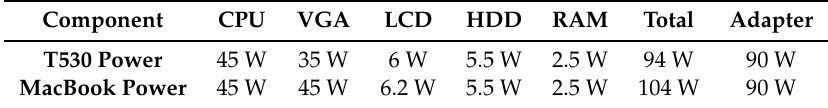
Table 1. Maximum power consumption of Lenovo T530-2359-A44 and Apple MacBook Pro 2013 components